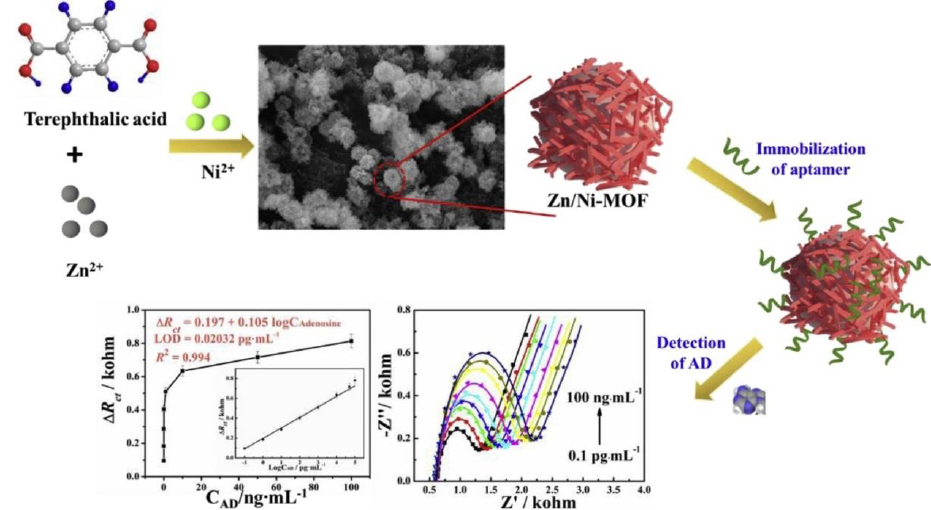
Figure 9. The synthesis process of a ZnNi MOF for AD detection. Reprinted with permission from Ref. [60]. Copyright 2019, Elsevier.